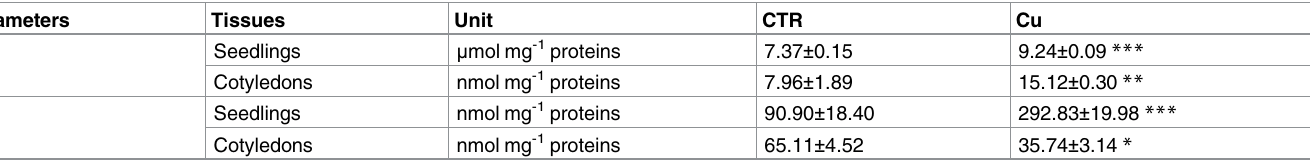
Table 2. Levels of protein carbonyl and thiol groups in the seedlings (3 days-old) and the cotyledons (9 days-old) of germinated bean seeds in the presenceof H 2 O (CTR) or 200 μ M Cu.